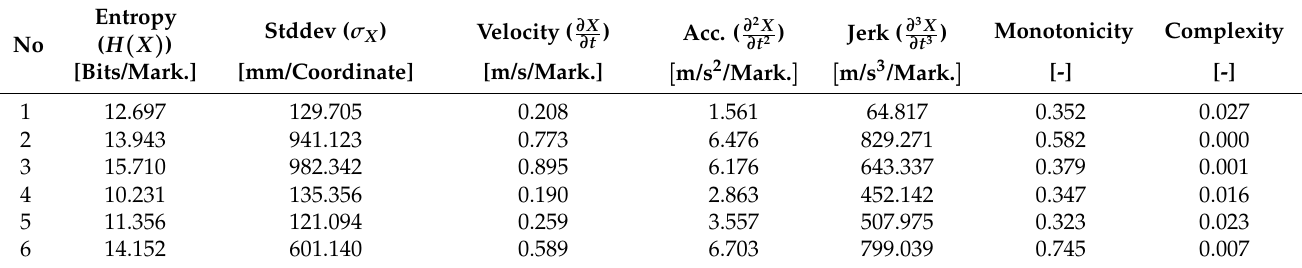
Table 2. Input sequence